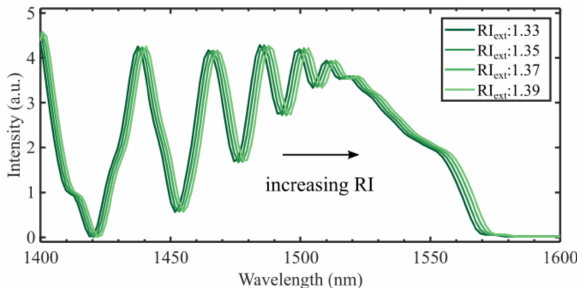
Figure 4. Refractive index sensitivity for a 14.2 mm CL fiber with a perfect cleave (zero degrees). The resulting sensitivity is 65.5 nm / RIU at 1550